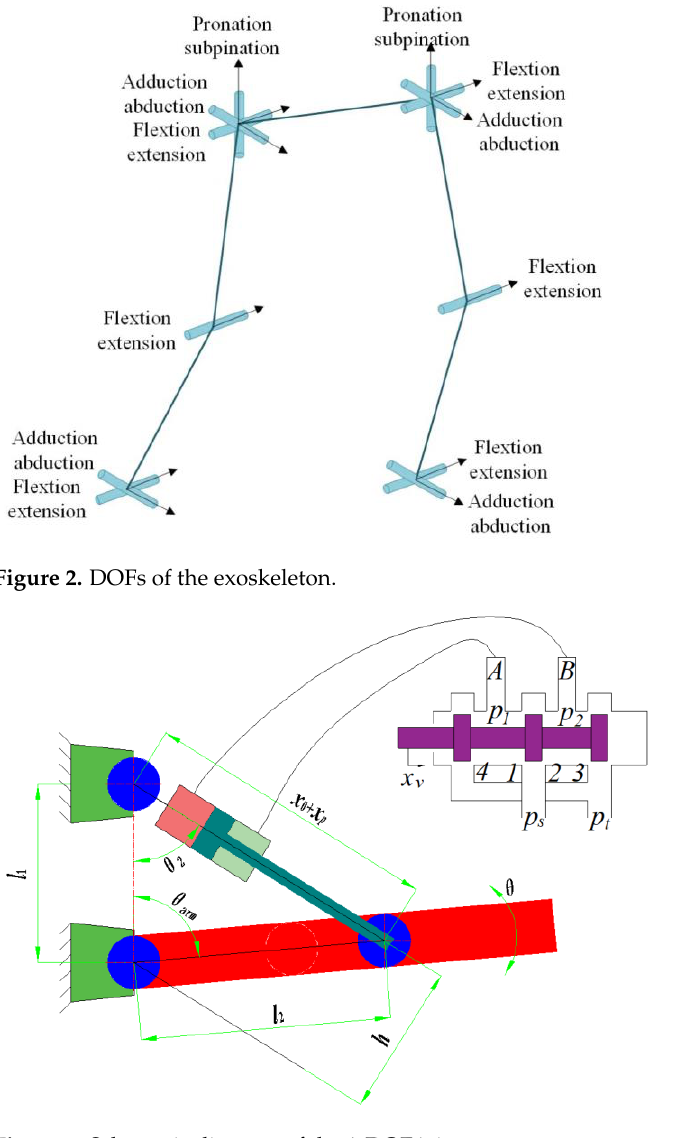
Figure 3. Schematic diagram of the 1-DOF joint system.